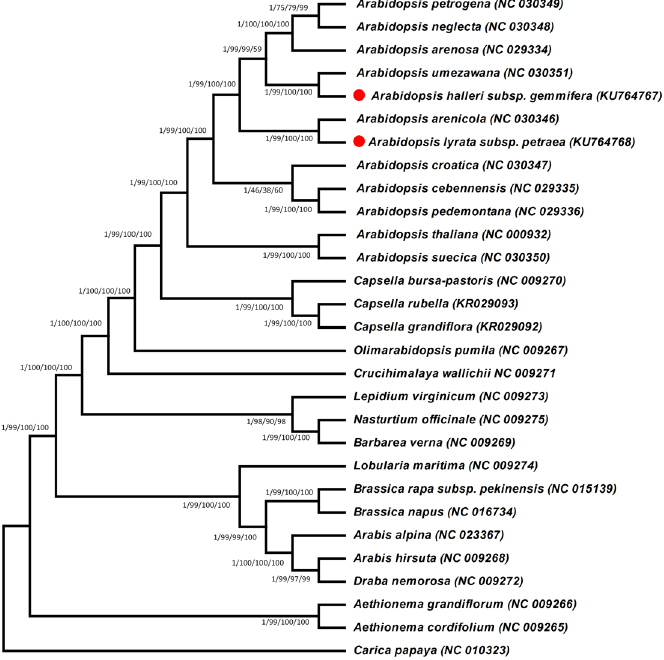
Figure 7. Phylogenetic trees were constructed for twenty-eight species from the family Brassicaceae using several different methods, and the tree shown is for the 70 shared protein coding genes. The following four different methods were used for the 70 shared genes data set: Bayesian inference (BI), maximum parsimony (MP), maximum likelihood (ML) and neighbour-joining (NJ). Numbers above the branches are the posterior probabilities of BI and bootstrap values for NJ, MP and ML. Stars represent the positions of A . halleri ssp. gemmifera and A . lyrata ssp. petraea